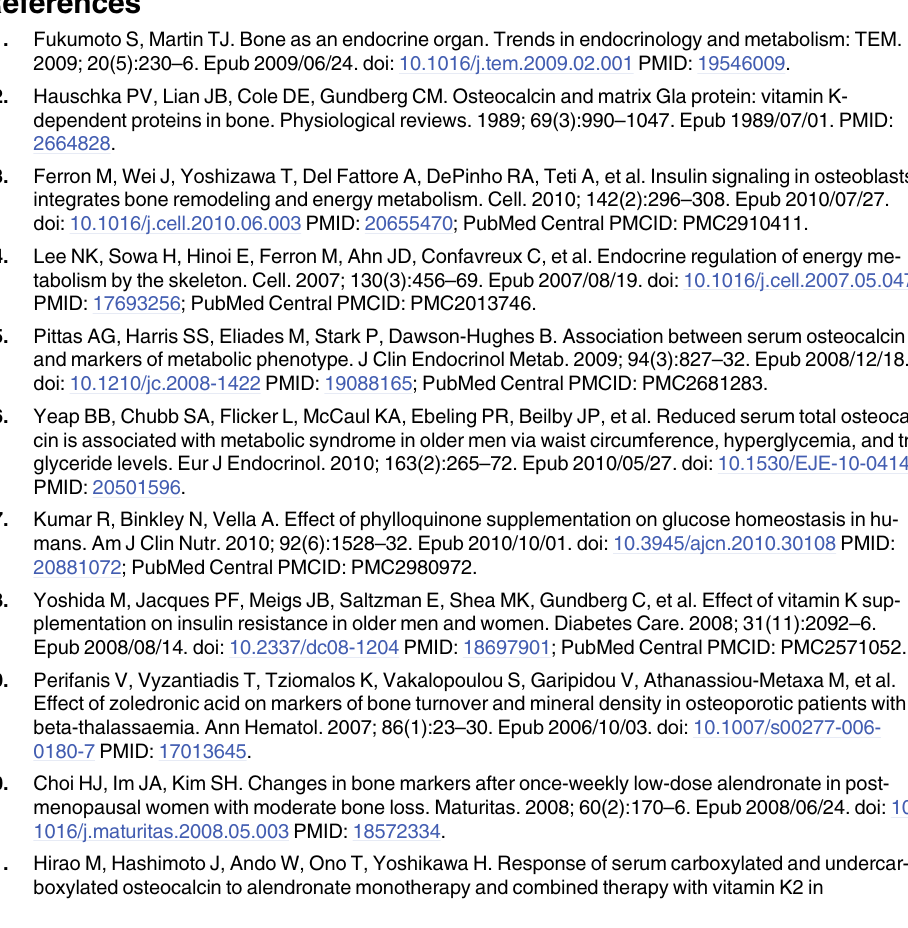
S1 Table. Demographic Characteristics of raloxifene users and matched non-exposed Group. S2 Table. Demographic Characteristics of Calcitonin users and matched non-exposed